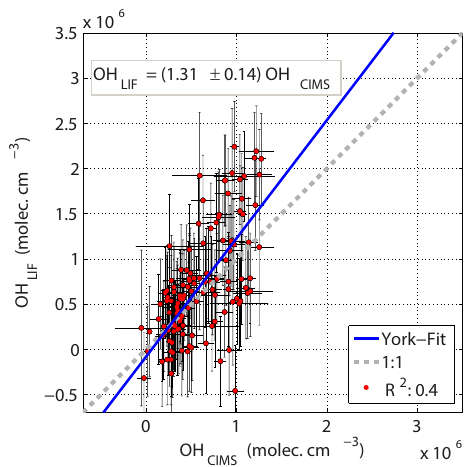
Figure 6. Comparison of on-ground OH measurements by IPI-LIF- FAGE technique and by CIMS (University of Helsinki, Petäjä et al., 2009) based on 30min average data. Error bars indicate the preci- sion of the associated measurements. Linear regression following the method by York et al. (2004) yields a slope of 1 . 31 ± 0 . 14 and an insignificant offset (offset: ( − 8 ± 9 ) × 10 4 moleccm − 3 ).